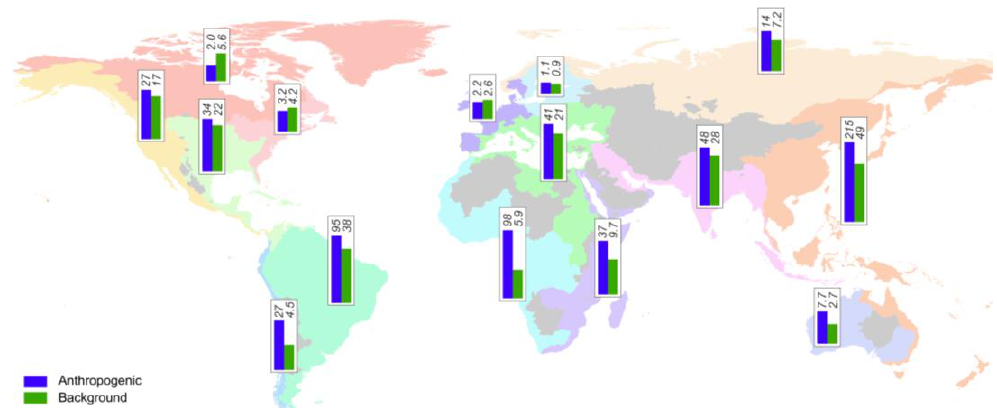
Figure 4. Sum of release estimates associated with anthropogenic activities (point sources, remobilization from contaminated systems and artisanal and small-scale gold mining ASGM) and background Hg release estimates for individual drainage basin. In the case of the sum of anthropogenic sources, we consider proportion of Hg released to land versus water in ASGM operations to be 50%. All units are in Mg·a −1 . For illustrative purpose we use log(x + 1) transformation to draw the bars.